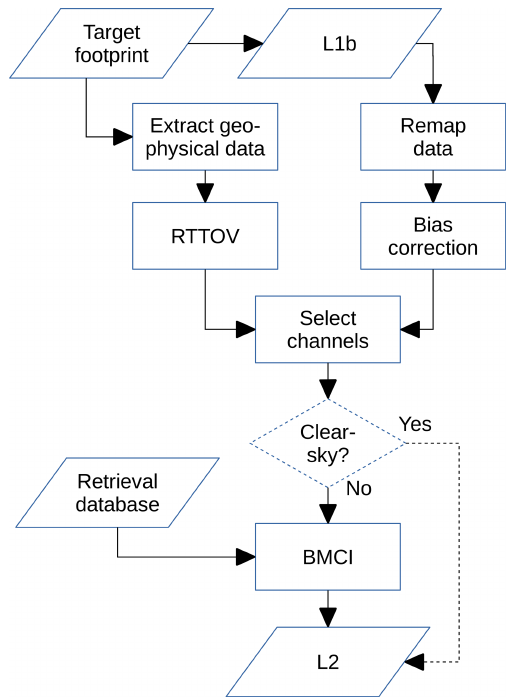
Figure 3. The overall data flow of the algorithm.